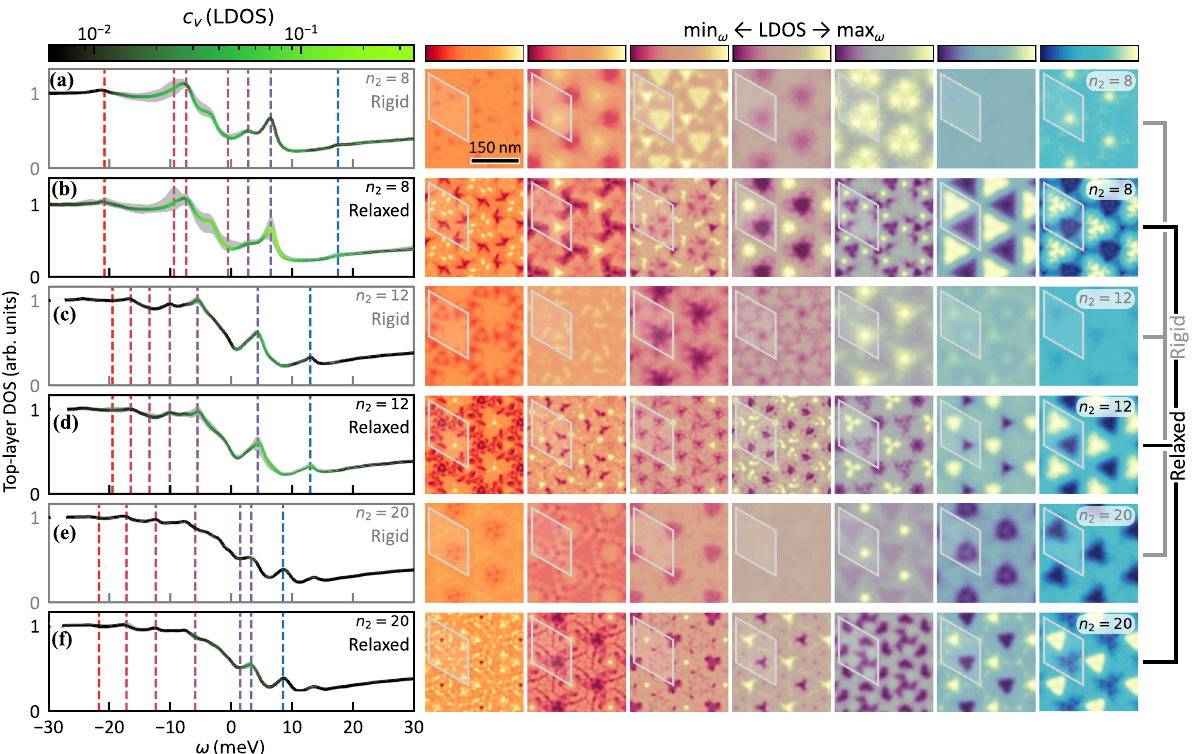
FIG. 5. Electronic structure properties for graphite on graphite at twist angle of θ ¼ 0 . 1 °. Each row (a) – (f) corresponds to the same system where we vary the number of graphene layers in the top flake ( n 2 ) and relaxed or rigid atomic structures across rows. Left subpanels: frequency ( ω ) resolved DOS of the outermost layer of the top graphite flake. Panels (a),(c),(e) represent simulations using rigid structures, and panels (b),(d),(f) relaxed structures. The number of layers of the bottom flake is fixed at n 1 ¼ 20 . We color σ = μ ) of the LDOS in the top layer as a function of ω . Light green indicates strong spatial code the coefficient of variation ( c v ¼ variations in the top-layer LDOS, whereas black corresponds to a uniform LDOS. The gray area in the background of the curves indicates the minimum and maximum values of the LDOS. Right subpanels: spatial distribution of the LDOS in the outermost layer at a given frequency. The frequencies are indicated in the left subpanels as dashed, colored vertical lines varying from red (low frequencies) to blue (high frequencies). The color maps for the LDOS maps are chosen to be consistent with this coloring. Light (yellow) regions correspond to high intensity and dark (red → blue) regions to low intensity. For each configuration, the rigid (gray) and relaxed (black) panels in two subsequent rows share a color scale to make differences visible. The system ’ s unit cell is indicated in each of the small subpanels. All plots on the right-hand side share the scale bar plotted in the top left